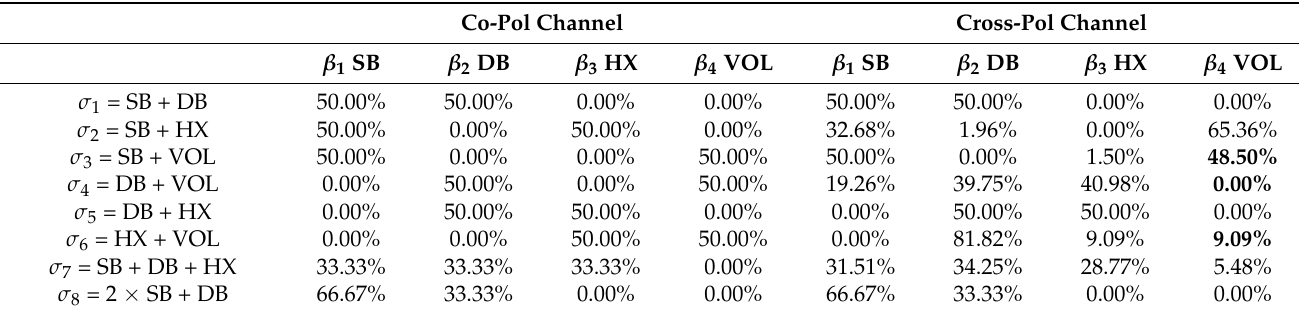
Table 5. Results of SA-based decomposition for linear combinations of synthetic signatures (co- and cross-polarized channels). Recognized signatures are specified in percentage.